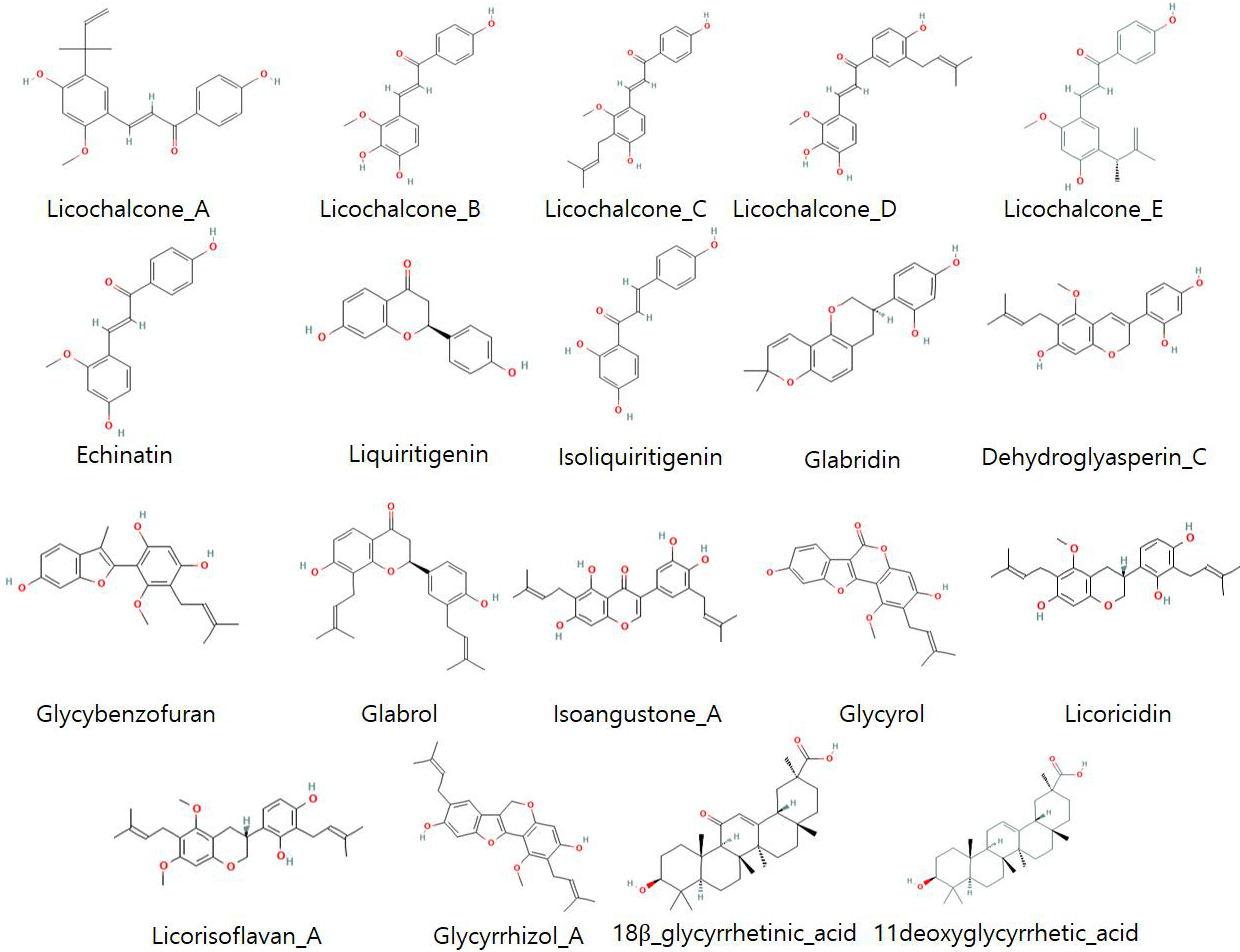
Figure 4. The 2D structure analysis of licorice compounds. Table 1. Recent biological activities of selected